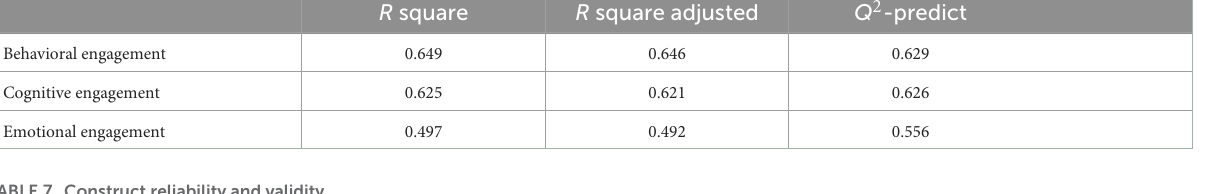
TABLE 7 Construct reliability and